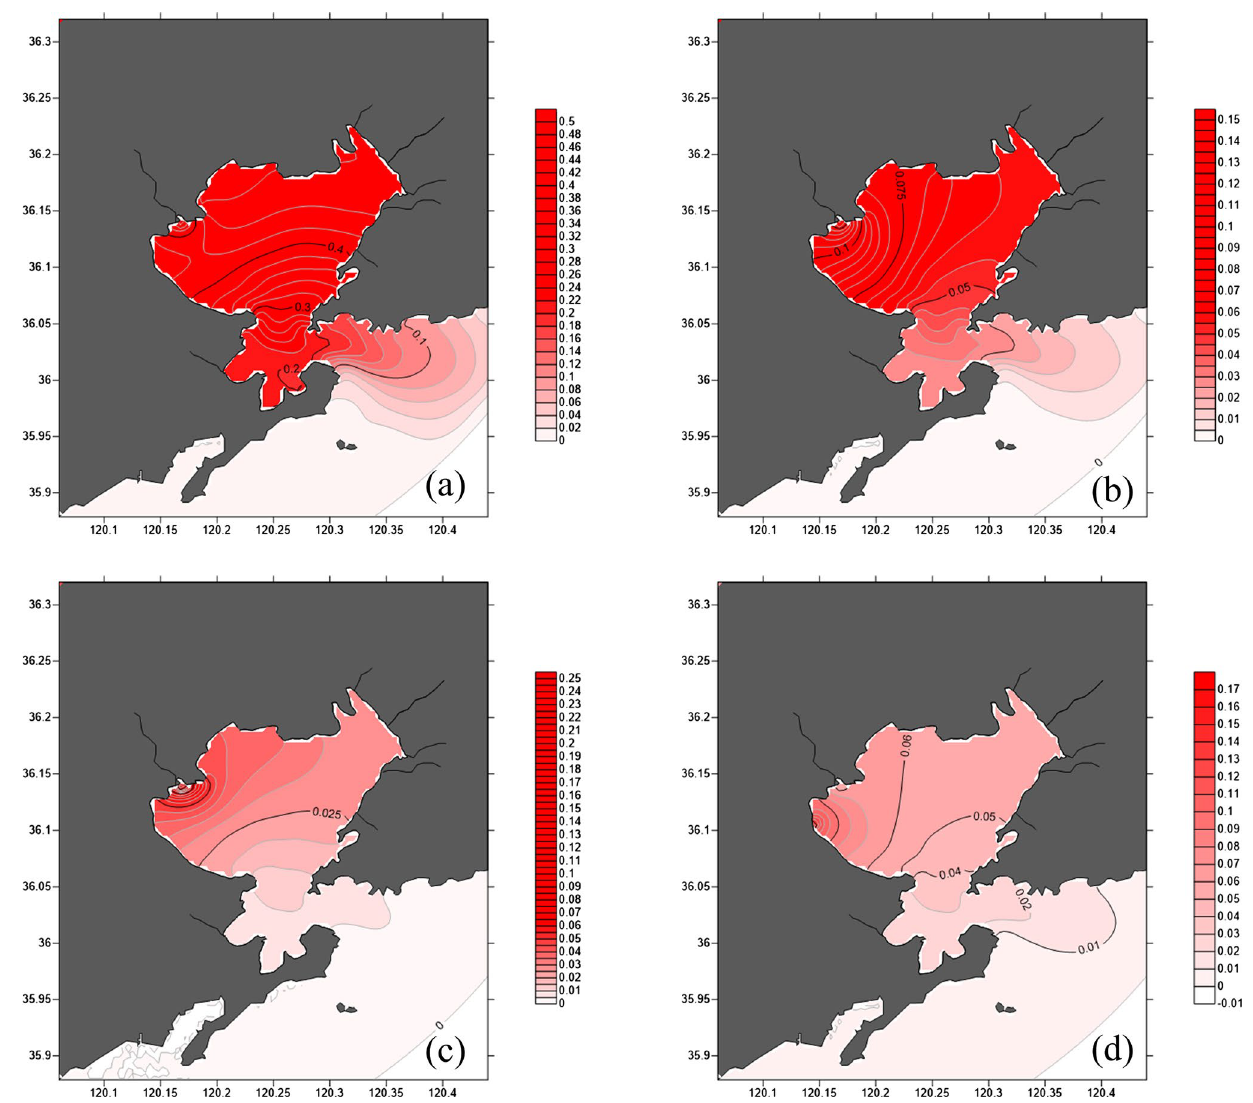
Fig. 12 Concentration distribution of TN and TP under different situations in Jiaozhou Bay, TN: a present situation, b after measure 7; TP: c present situation, d after measure